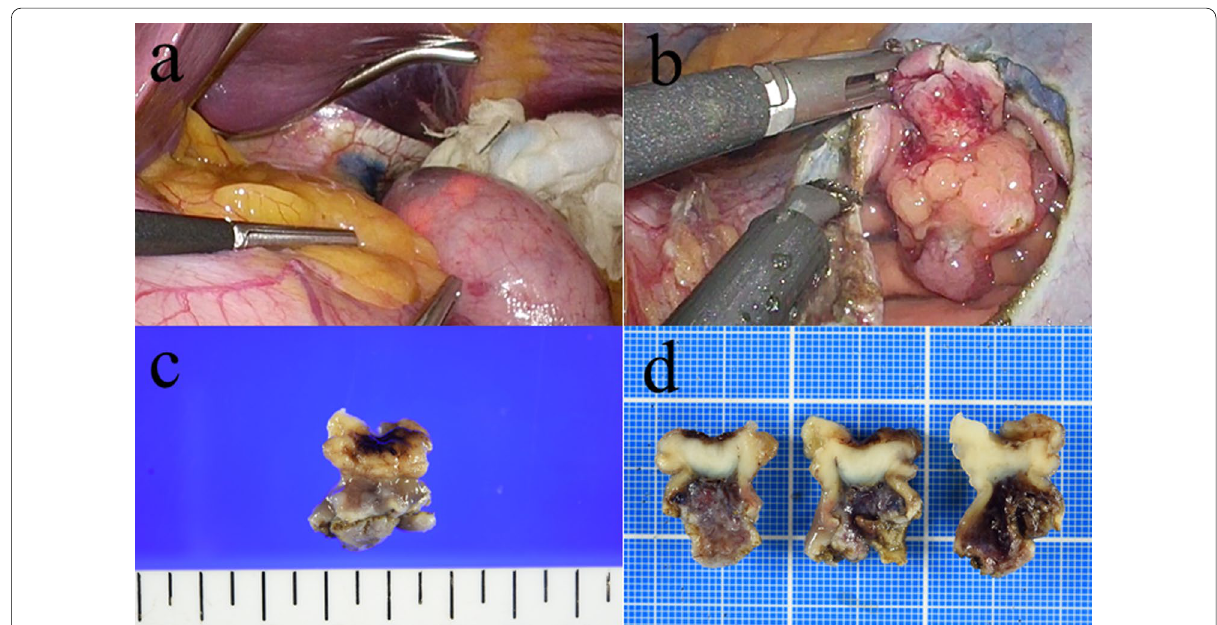
Fig. 2 Intraoperative findings and resected specimen. The periphery of the tumor was marked by injecting indigo carmine and hyaluronic acid into the submucosal layer ( a ); the stomach was dissected along the marked incision line laparoscopically ( b ); macroscopically, the tumor measured